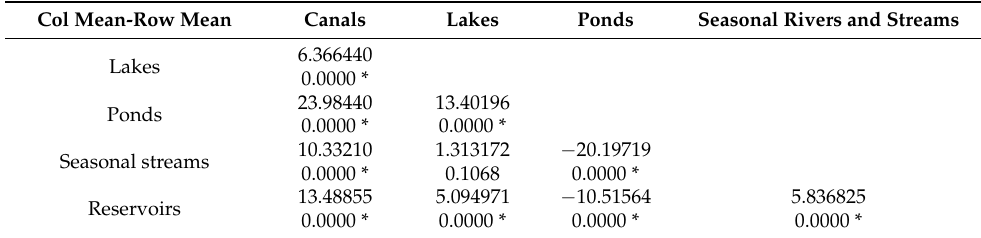
Table A7. 2020 Dunn’s post hoc tests, with p -values adjusted with the Bonferroni